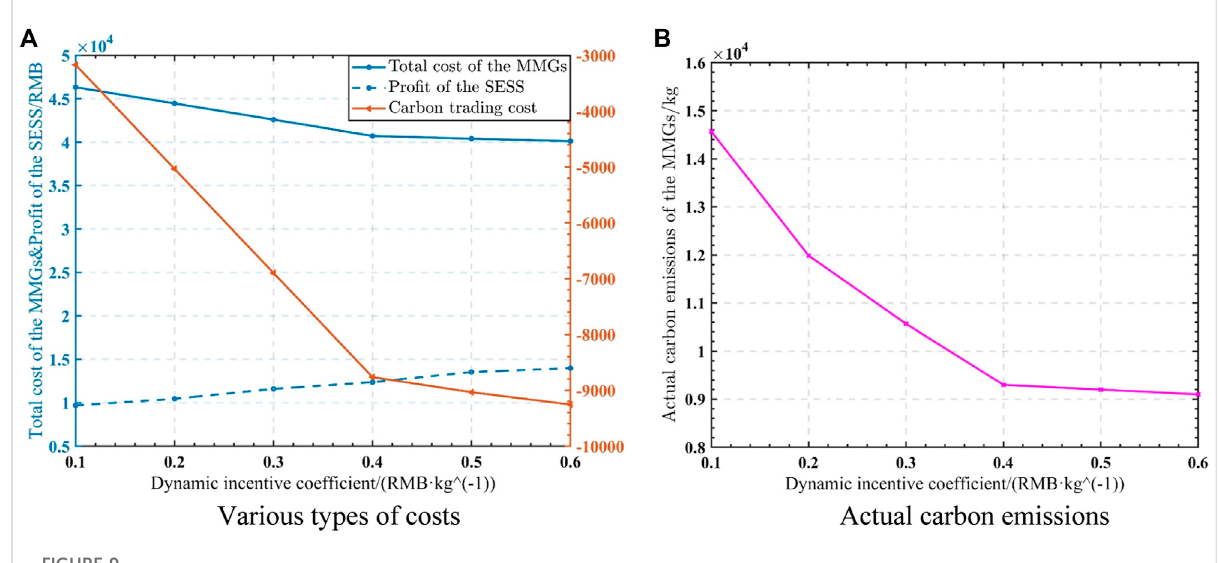
FIGURE 9 Curvesofvarioustypesofcostsandactualcarbonemissionswiththedynamicincentivecoef fi cient: (A) varioustypesofcosts; (B) actualcarbon